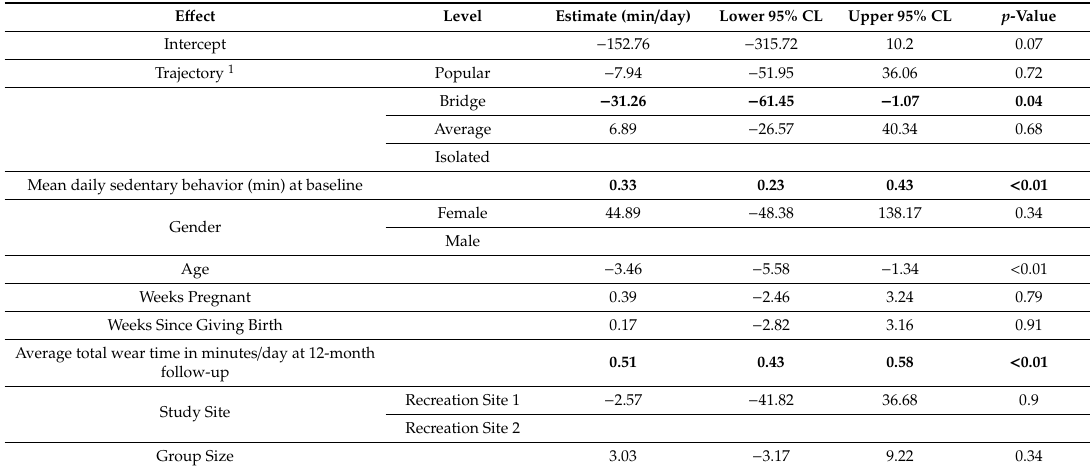
Table 3. Multilevel regression predicting minutes of sedentary behavior at 12-month follow-up from network trajectory over the first 12 weeks of the intensive group phase of the intervention. E ff